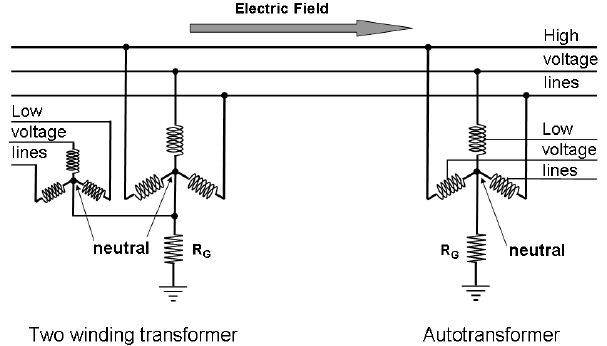
Figure 1. Three-phase transmission lines and substations with a two-winding transformer and an authotransformer.